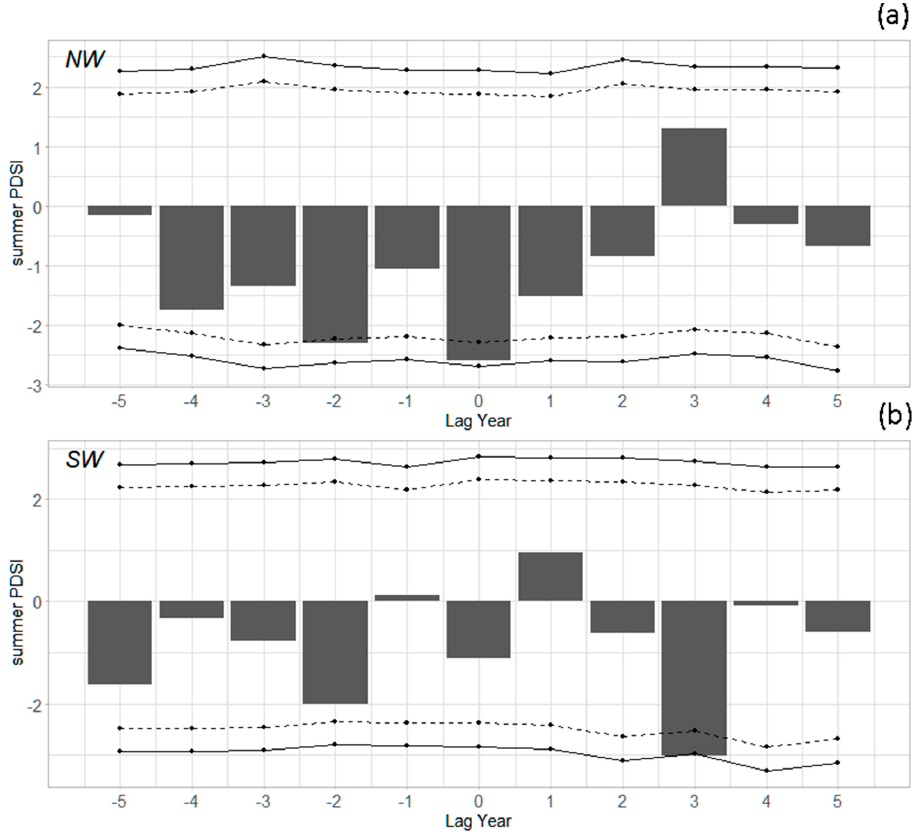
Figure 5. Superposed epoch analysis of summer Palmer Drought Severity Index (PDSI). ( a ) Mean of regions in the Northwest ( N = 5); ( b ) mean of regions in the Southwest ( N = 3). Dotted lines indicate 90% confidence intervals, and solid lines indicate 95% confidence intervals. Values outside these intervals are years when the climate was statistically significantly different from average conditions.